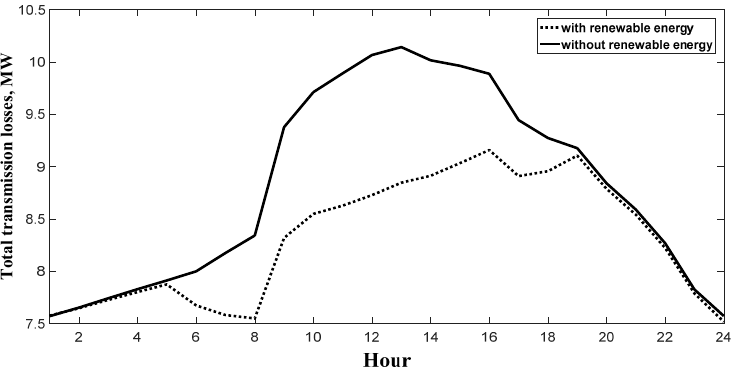
Figure 7. Total transmission losses with and without renewable energy, MW.